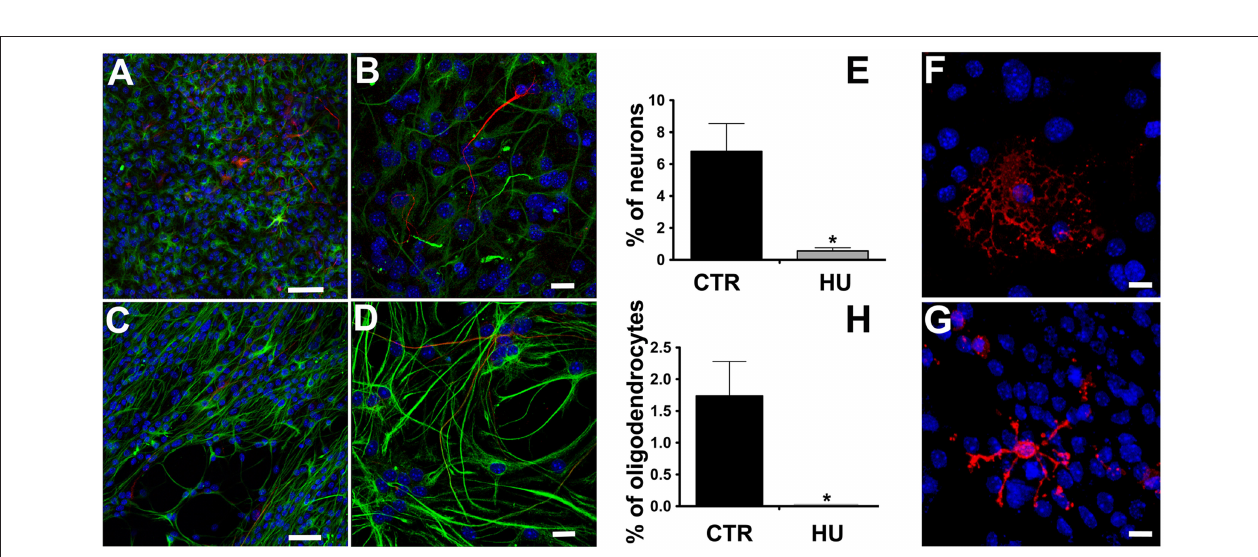
FIGURE 4 | Immunostaining of the differentiated cells. β -tubulin III (red, Alexa 555 Goat anti-mouse antibody) and GFAP (green, Alexa 488 Goat anti-rabbit antibody), nuclei (blue, DAPI) staining. (A , C) Bar 50 µ m. (B,D) higher magnification, Bar 20 µ m. (E) Quantitative analysis of β -tubulin III marker expression in CTR ( n = 4) and HU ( n = 4), * p < 0.05. O4 (red, Alexa 555 Goat anti-mouse antibody), nuclei (blue, DAPI) staining (F) CTR, (G) HU. (H) Quantitative analysis of O4 marker expression in CTR ( n = 4) and HU ( n = 4), * p < 0.05. Bars 20 µ m.